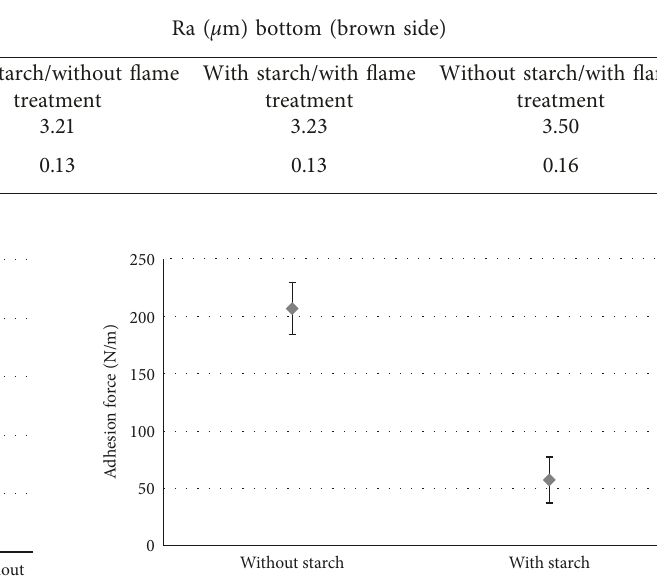
Figure 4: Influence of starch application on the adhesion force between the polyethylene and the flame-treated bottom surface of the